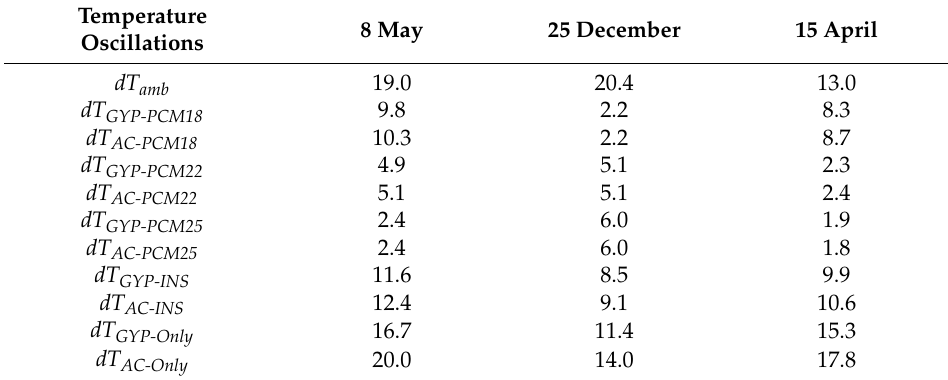
Table 8. Indoor and ambient (outdoor) temperature oscillations for all case scenarios on 8 May,